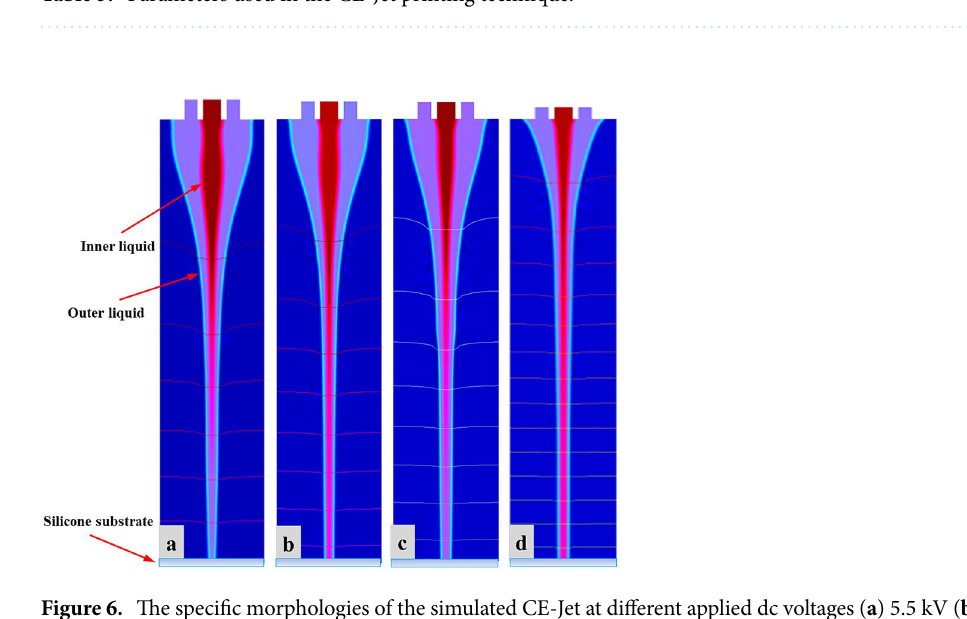
Table 3. Parameters used in the CE-Jet printing technique.